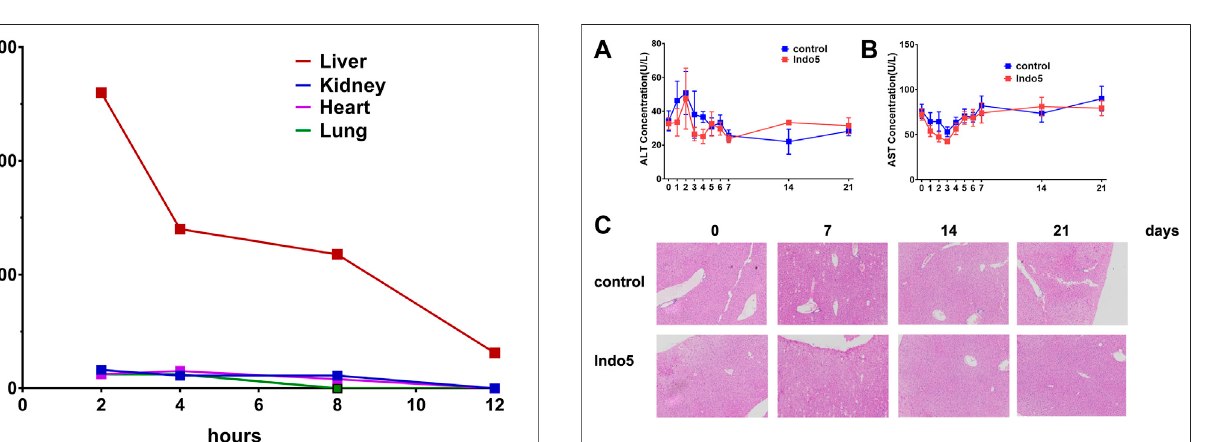
FIGURE 5 | Concentration – time pro fi les after oral administration of Indo5 in the rat liver, kidneys, heart, and lungs at a dose of 100 mg/kg ( n (cid:2) 3).